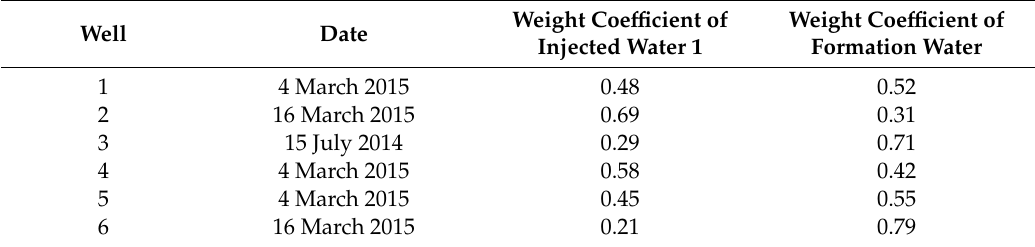
Table 7. Weight coe ffi cient of formation and injected water in the produced water before 28 May 2015. Well Date